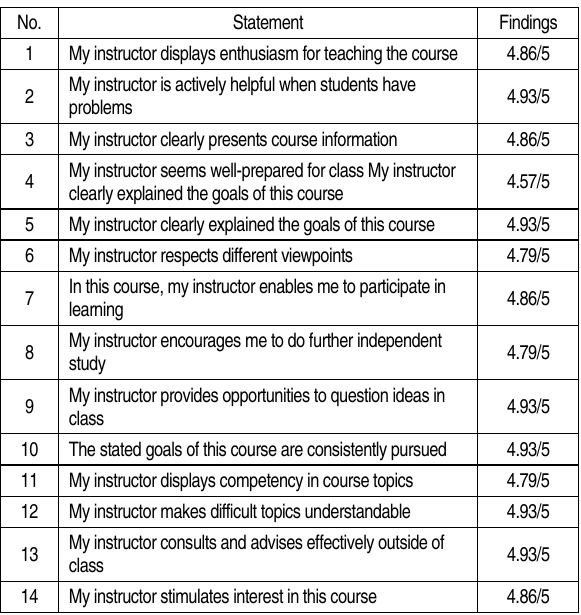
Table 2. Student evaluations of teaching